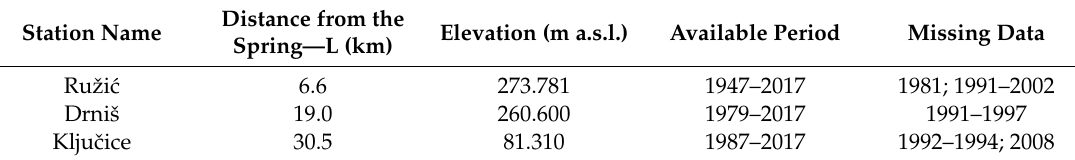
Table 1. Main characteristics of the three analyzed hydrological stations along the ˇCikola